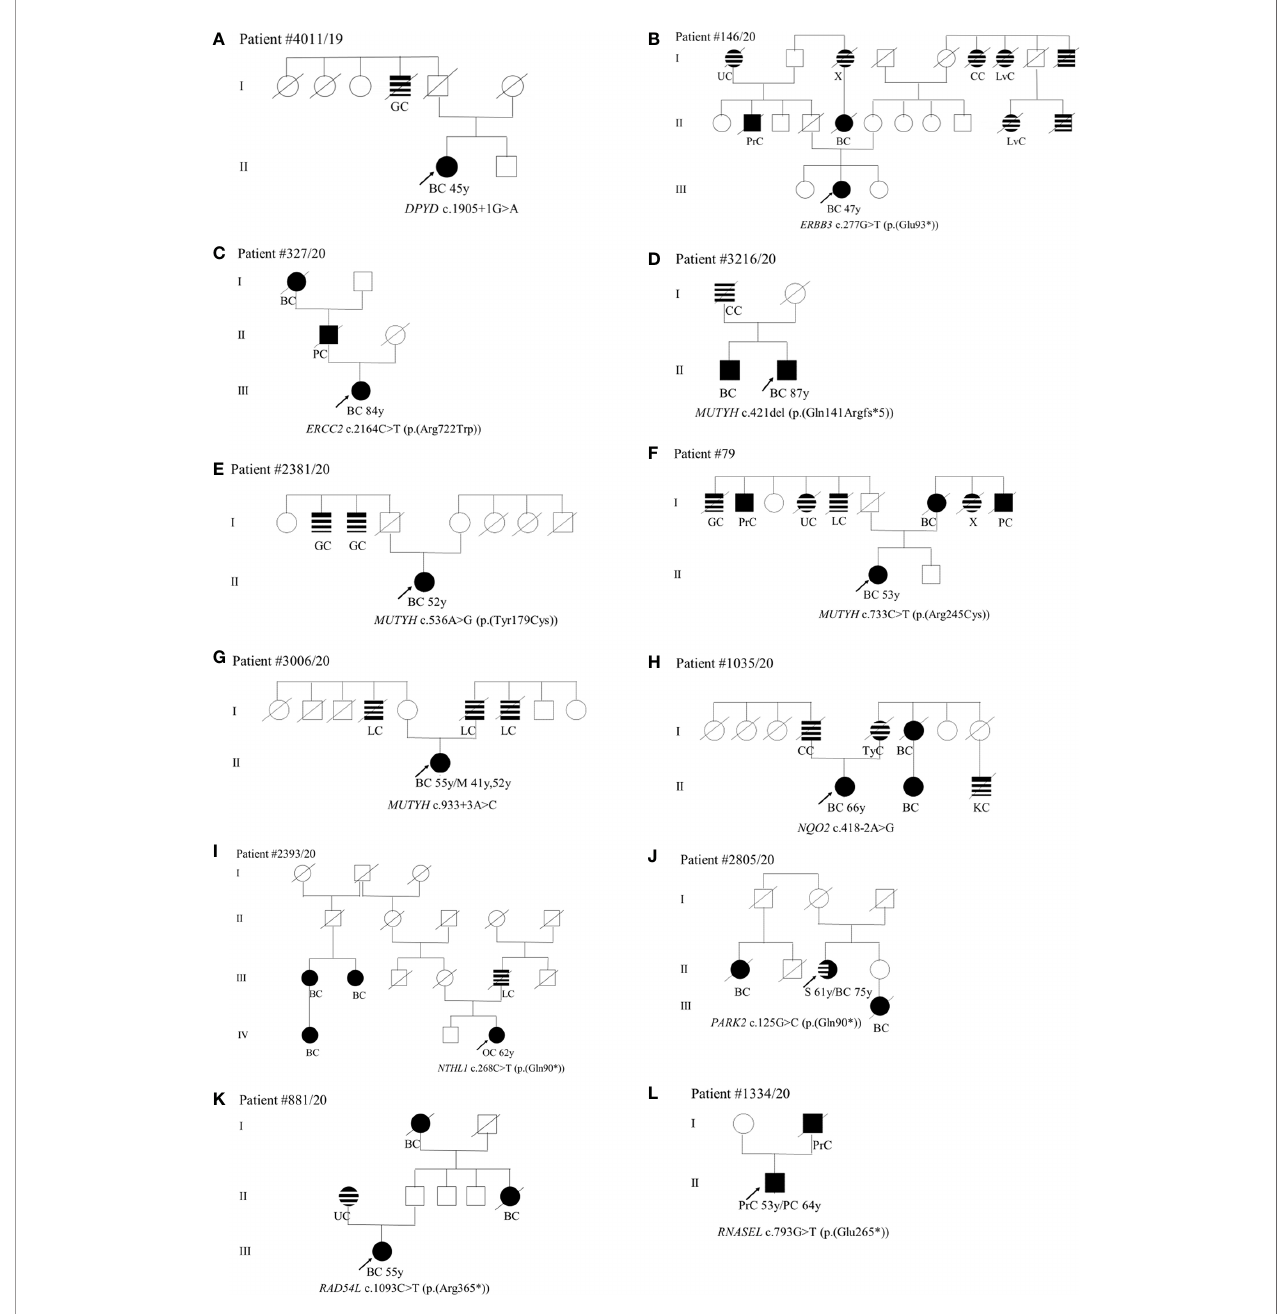
FIGURE 2 | (A – L) Pedigrees of patients carrying pathogenic variants in non-canonical genes. The gene and their variants are reported below the symbol of each proband. The arrows indicate the proband from each family. The black symbols indicate “ HBOC-spectrum phenotypes ” while striped symbols indicate “ other neoplasms. ” Abbreviations as in Figure 1